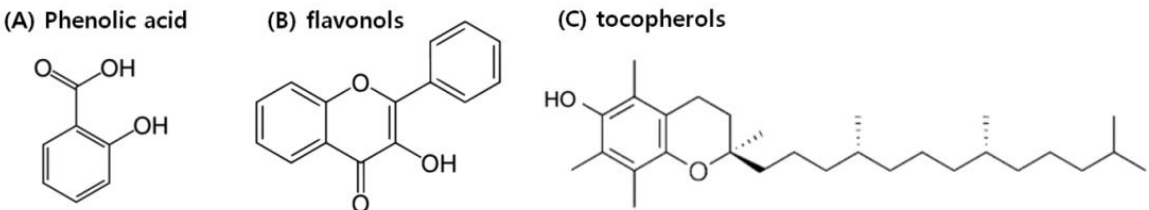
Figure 2. Phytochemicals of immature Morus alba L. fruits. Structure of ( A ) phenolic acid, ( B ) flanovols, and ( C ) tocopherols.